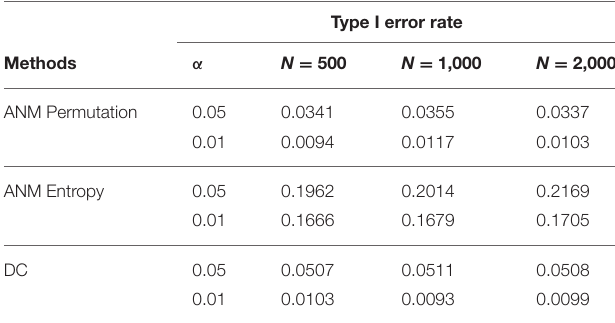
TABLE 3 | Average type 1 error rates of three statistics for testing causation, assuming presence of association.